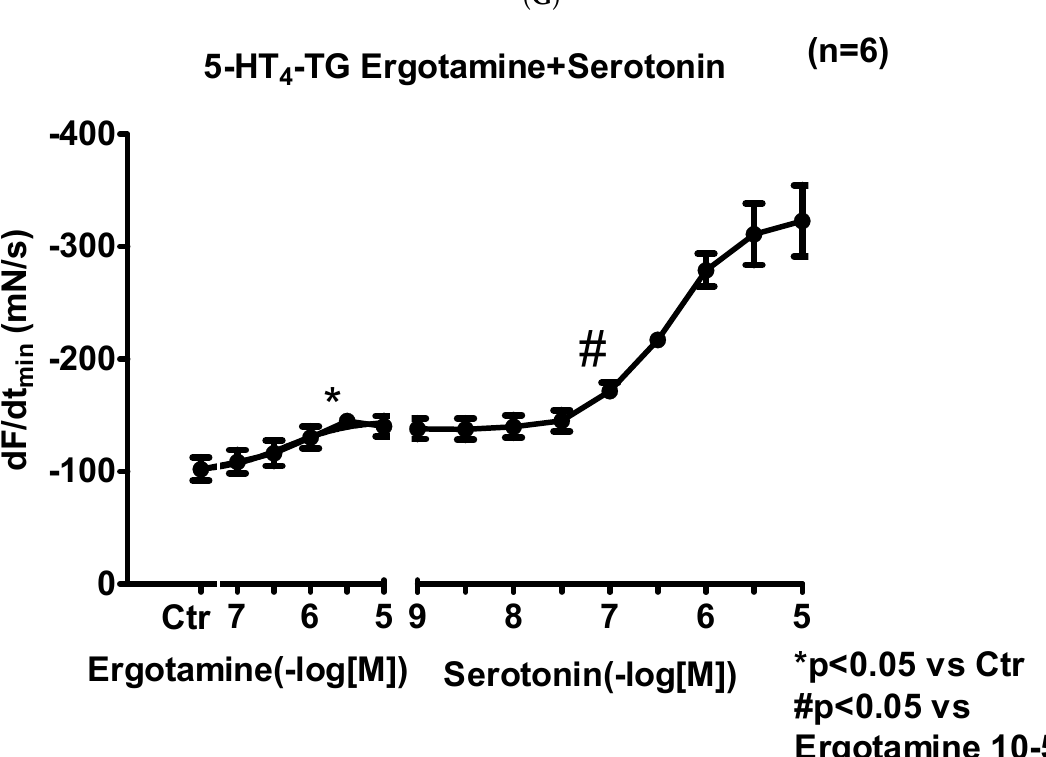
Figure 4. Ergotamine increases force in 5-HT 4 -TG. ( A ) Original recording in mouse left atrial prepa- rations from 5-HT 4 -TG. It becomes apparent that ergotamine induced a time- and concentration- dependent positive inotropic effect. ( B ) Original recordings in mouse left atrial preparations from WT. It becomes apparent that ergotamine did not induce a time- and concentration-dependent pos- itive inotropic effect. ( C ) Summarized concentration–response curves for the effect of ergotamine or histamine on force of contraction. ( D : T1) Time to peak tension. ( E : T2) Time to relaxation. ( F : dF/dt max ) Rate-of-tension development. ( G : dF/dt min ) Rate-of-tension relaxation in 5-HT 4 -TG left atria. * p < 0.05 vs. Ctr, first significant difference versus control (pre-drug value, Ctr). Ordinates in ( A – C ): force of contraction in milli-Newton (mN). Ordinate in ( D ) time to peak tension in milli sec- onds (ms). Ordinate in ( E ) time of relaxation in milli seconds (ms). Ordinate in ( F ) rate of contraction in mN/s and ordinate in ( G ) rate of relaxation in mN/s. Horizontal bars in ( A , B ) indicate time in minutes (min). Abscissae in ( D – F ) indicate concentrations of ergotamine or histamine in negative decadic molar concentrations. Significant differences versus control (CTR; pre-drug value) is indi- cated in asterisks. “n” indicates number of experiments. 2.2.2. Right Atrium In right atrial preparations from 5-HT 4 -TG, ergotamine increased the beating rate as seen in an original recording (Figure 5A). Additionally applied serotonin hardly increased the beating rate any further in 5-HT 4 -TG (Figure 5A). Ergotamine failed to increase the beating rate in WT. Several such experiments are summarized in Figure 5B: Ergotamine concentration-dependently increased the beating rate in isolated right atrial preparations (Figure 5B). This effect was also antagonized by subsequently applied tropisetron.